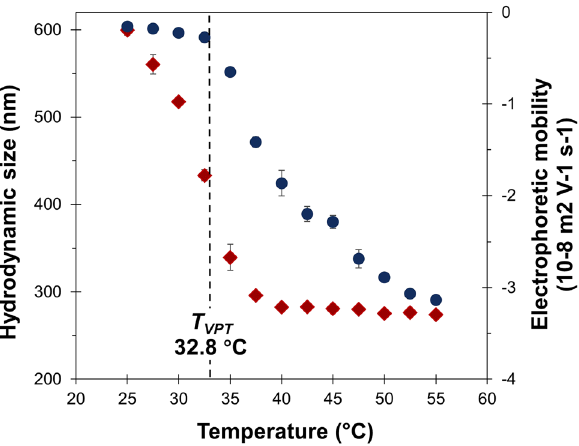
Figure 2. The effect of temperature on hydrodynamic particle size (red rhombus) and electrophoretic mobility (dark blue circle) of the crosslinked thermally-sensitive